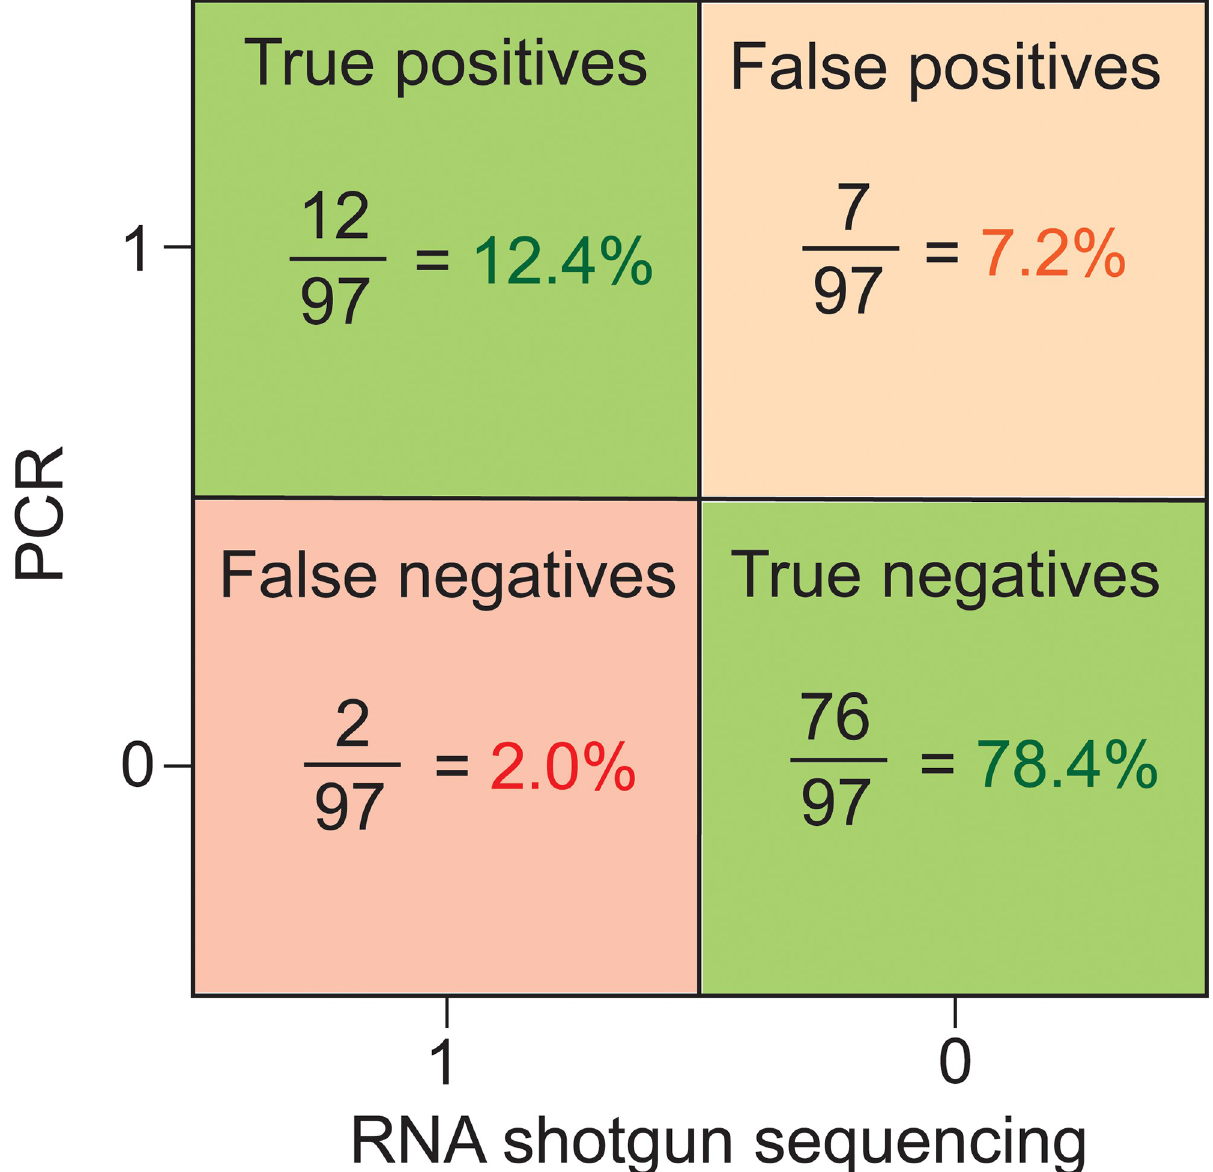
Fig 4. Accuracy of PCR and RNA metagenomic sequencing. RNA shotgun sequencing was used as the ‘true’ reference test. In cases with co- infections, true positive means that both diagnostic approaches found both viruses.